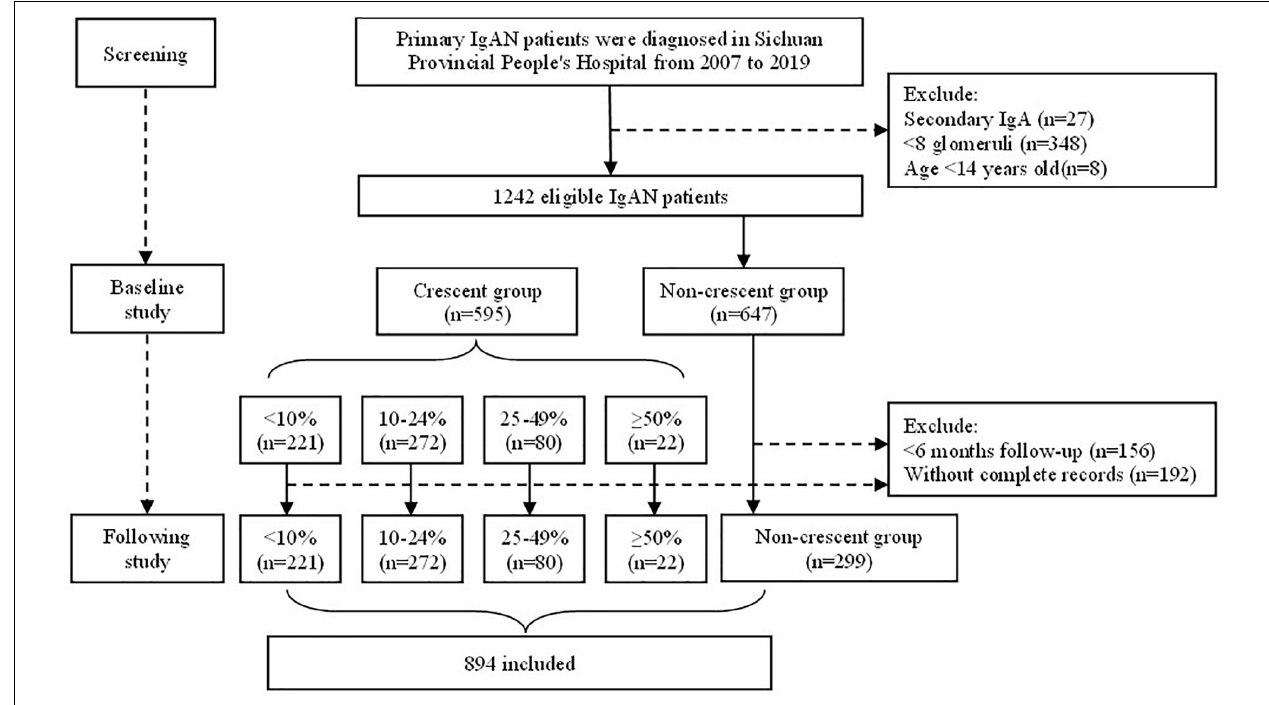
FIGURE 1 | The flow chart of the enrolment of IgAN